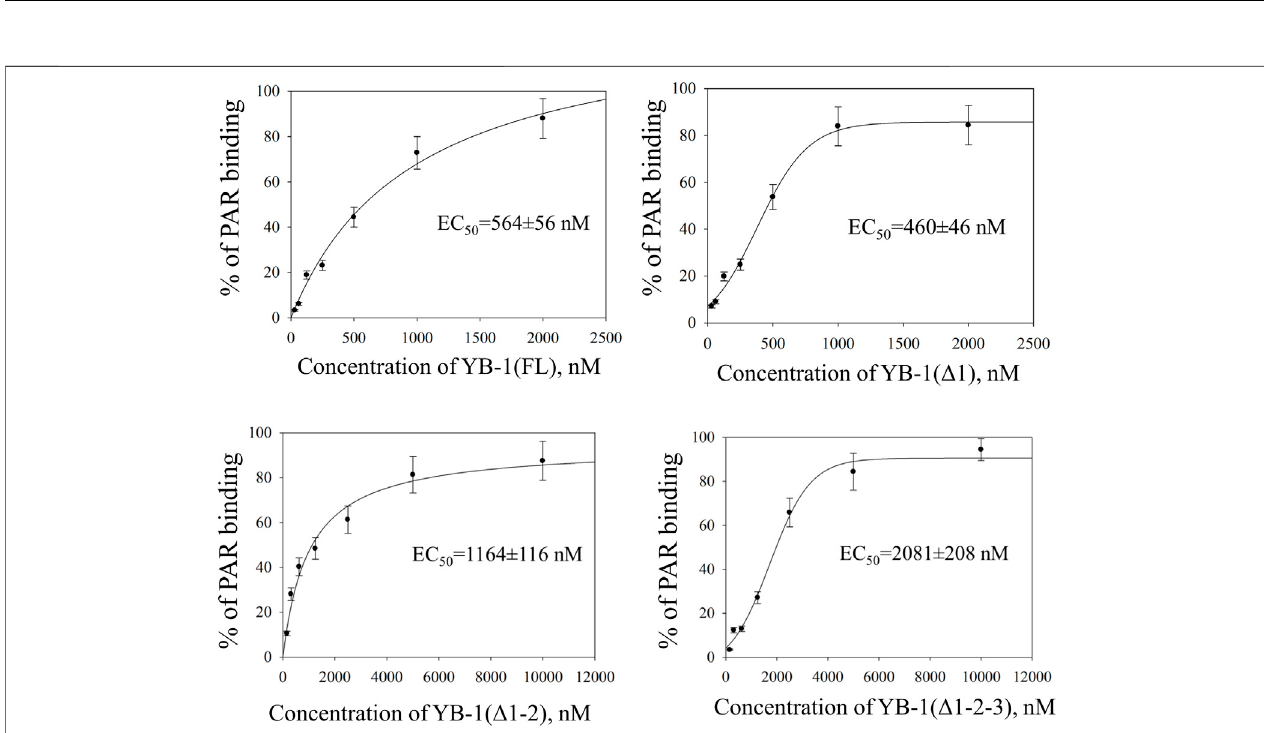
FIGURE2| CTDshorteningweakensYB-1af fi nityforPAR.Graphsshowquanti fi cationofEMSAdata( SupplementaryFigureS1 )andrepresentthemeanvalues of three independentexperiments with error bars (±SD). The binding parameters (EC 50 ) of YB-1 interaction with PAR wasdetermined asYB-1 concentration resulting in 50%substratebinding.EC 50 valuesarethemean(±SD)ofthreeindependentexperiments.Thereactionmixturescontained60 nM[ 32 P]-labeledPARandYB-1(FL)orits C-terminal deletion mutants at the indicated concentrations.